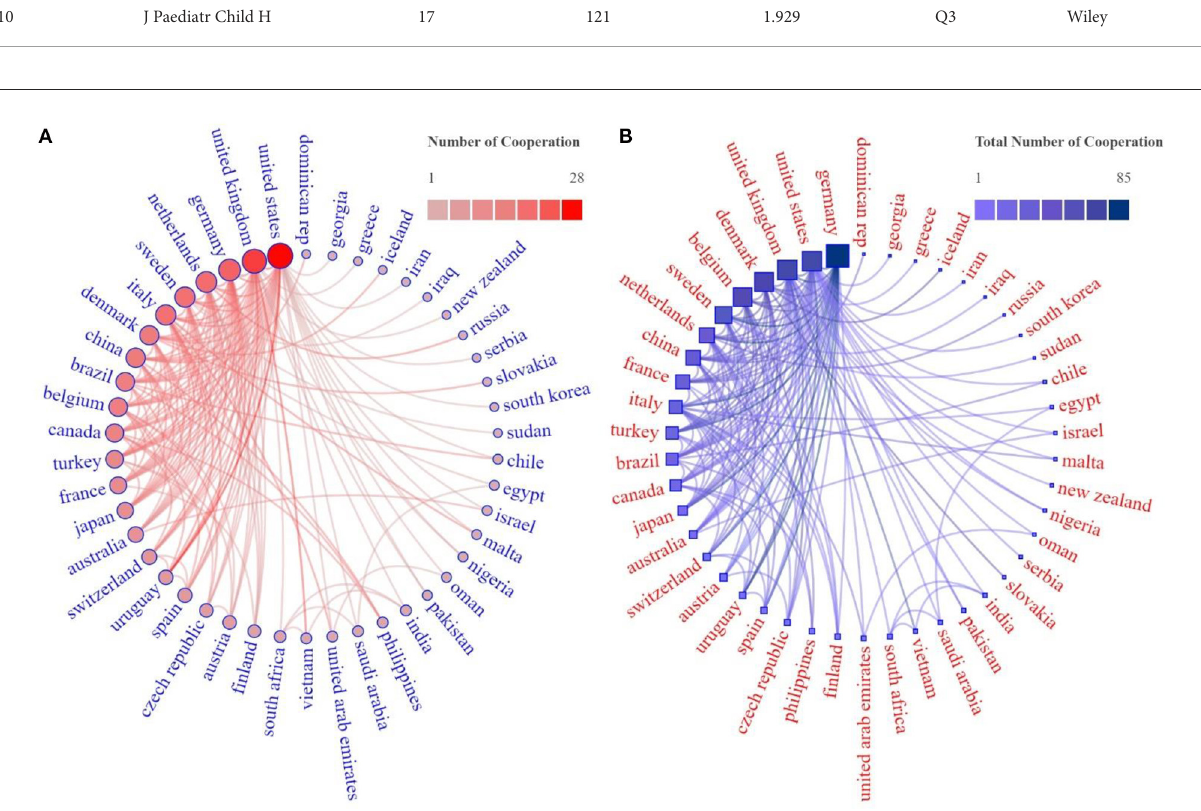
FIGURE3 Network of countries’ cooperation on NE. Each circle or square represents a country or region, the size of the area and the shade of the color inside represent the frequency of collaborations, and the lines represent collaborative relationships. (A) Numbers of cooperation with other countries. (B) Total times of